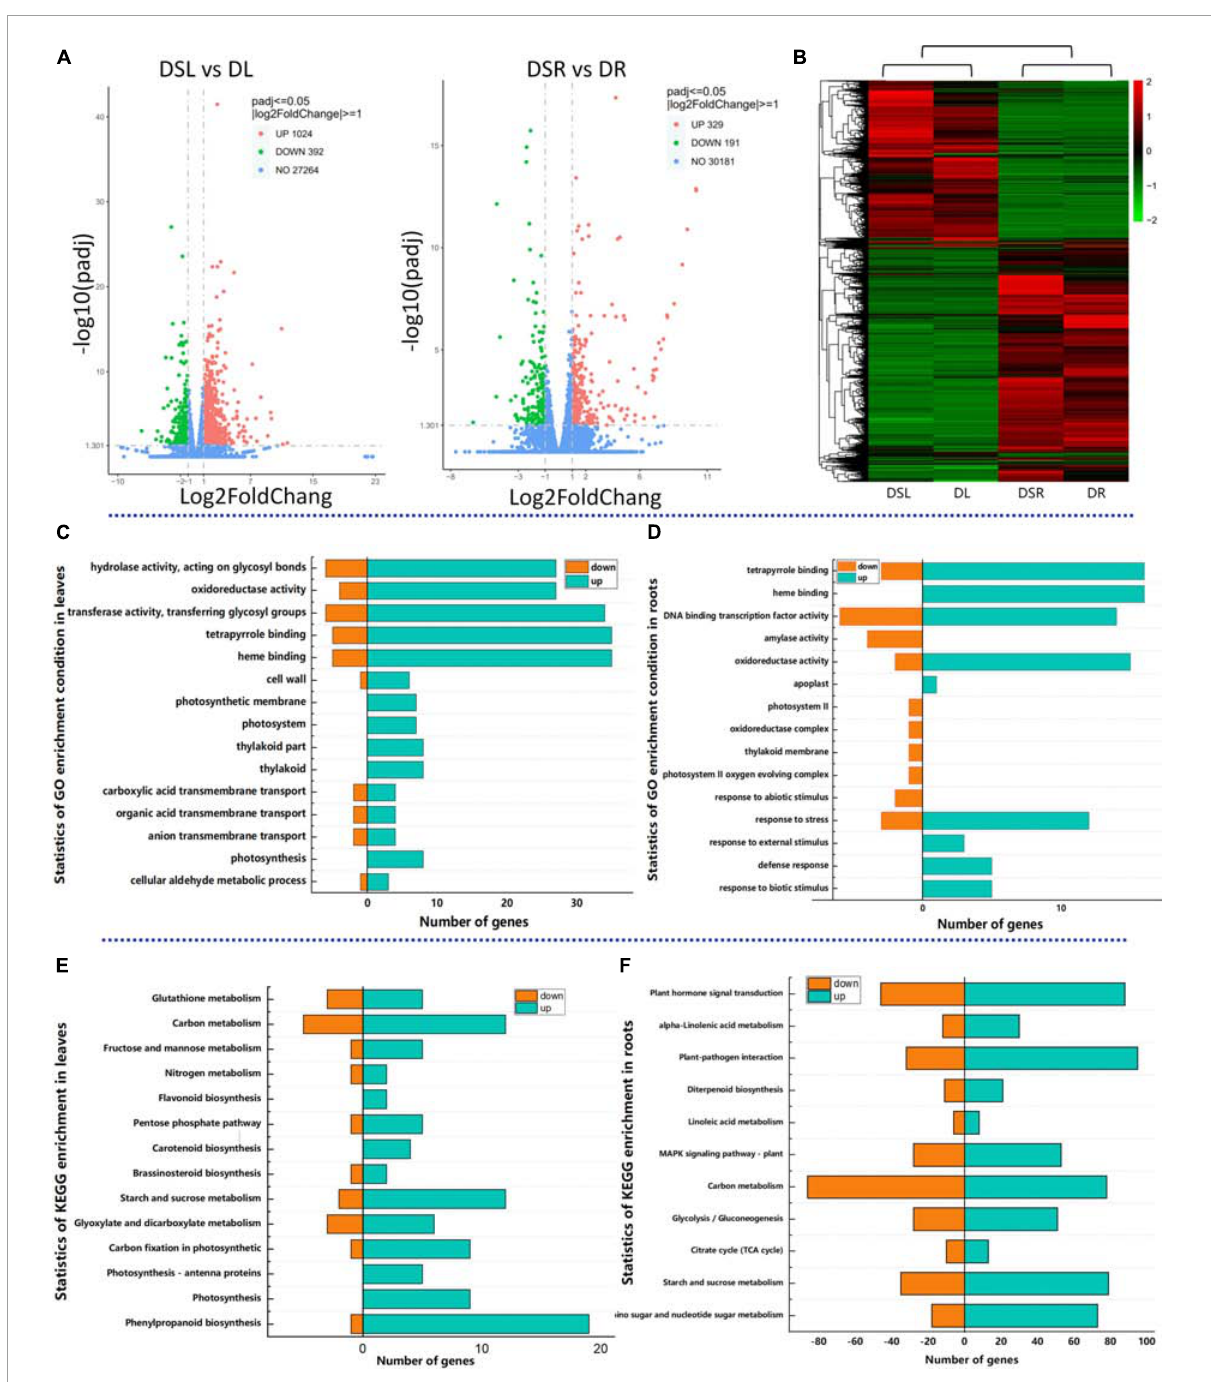
FIGURE2 Analysis of effect of Si on the transcriptome of rice under dry cultivation. Volcano plots of differentially expressed genes (DEGs). DEGs in leaves (left) and roots (right). The horizontal coordinate shows the log2FoldChange value, and the vertical coordinate shows the –log10 p adj or –log10 p -value. The blue dashed line indicates the threshold line for the differential gene screening criteria; Upregulated genes are in red, and downregulated genes are in blue (A) ; Cluster dendrogram of differentially expressed genes in Si-treated and no Si-treated rice under dry cultivation (B) ; GO enrichment with DEGs of leaves (C) ; GO enrichment with DEGs of roots (D) ; KEGG enrichment with DEGs of leaves (E) ; KEGG enrichment with DEGs of roots (F) ; The horizontal coordinate represents the ratio of the number of DEGs annotated in the GO/KEGG pathway, and the vertical coordinate represents the GO/KEGG pathway. DSL: Silicon-treated of rice under dry cultivation leaves; DL: Normal rice under dry cultivation leaves; DSR: Silicon-treated of rice under dry cultivation root; DR: Normal rice under dry cultivation